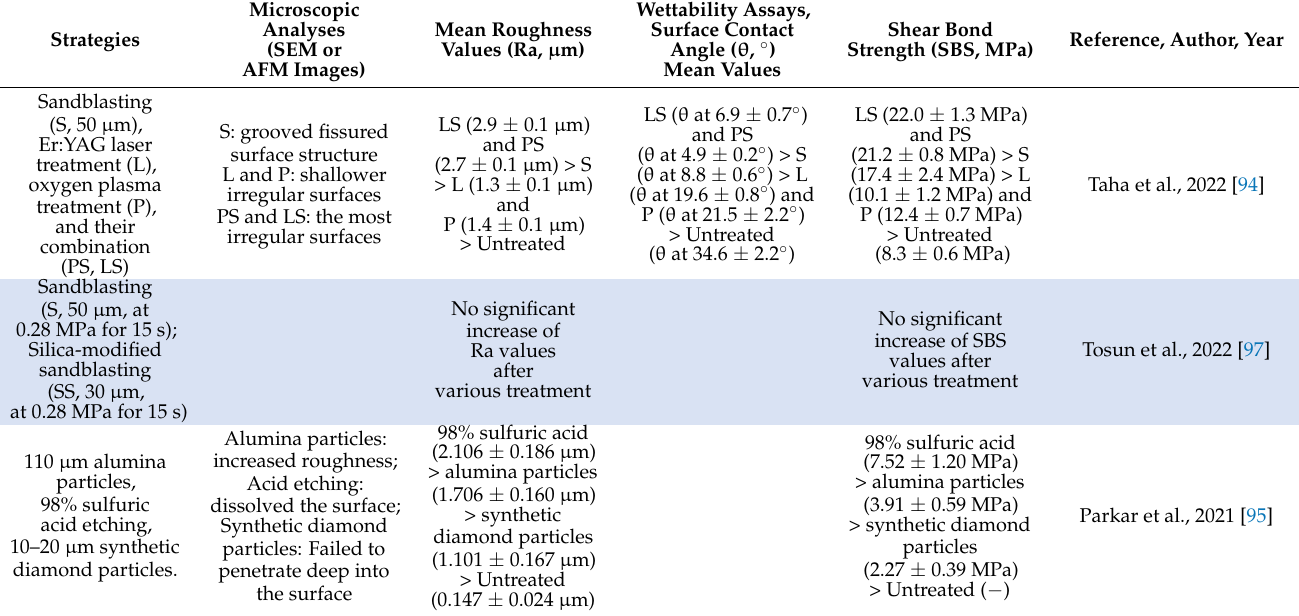
Table 4. The application of sandblasting for the improvement of PEEK adhesion